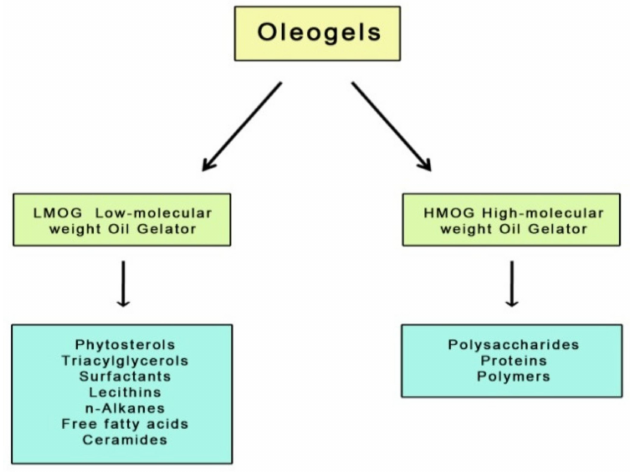
Figure 1. Gelator compounds of different molecular